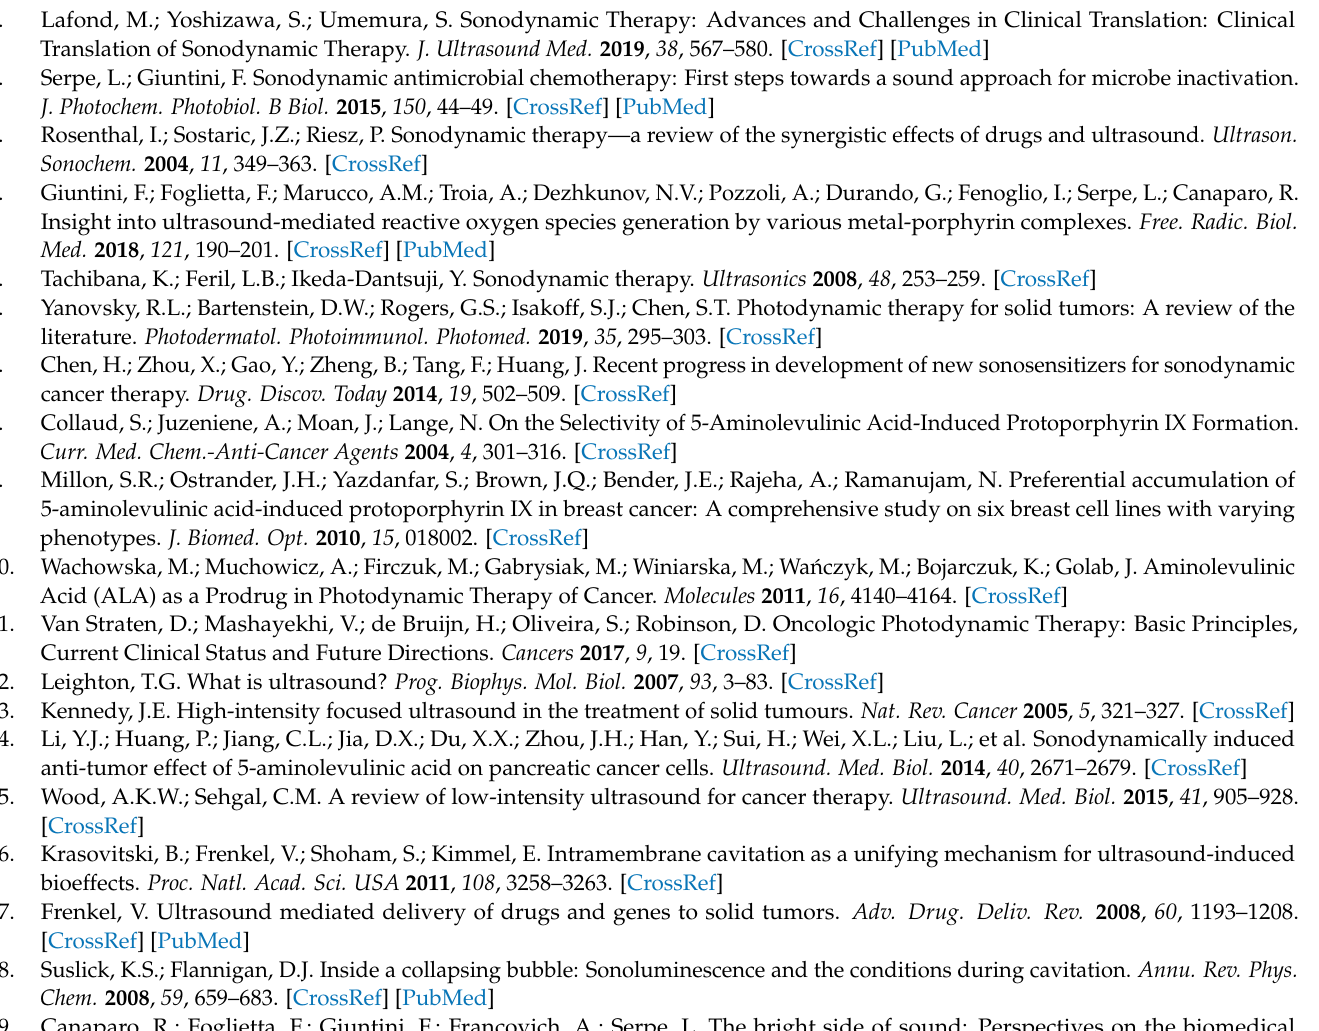
related to Figure 5; Table S9: Raw data of LC3 A/B protein expression after SDT